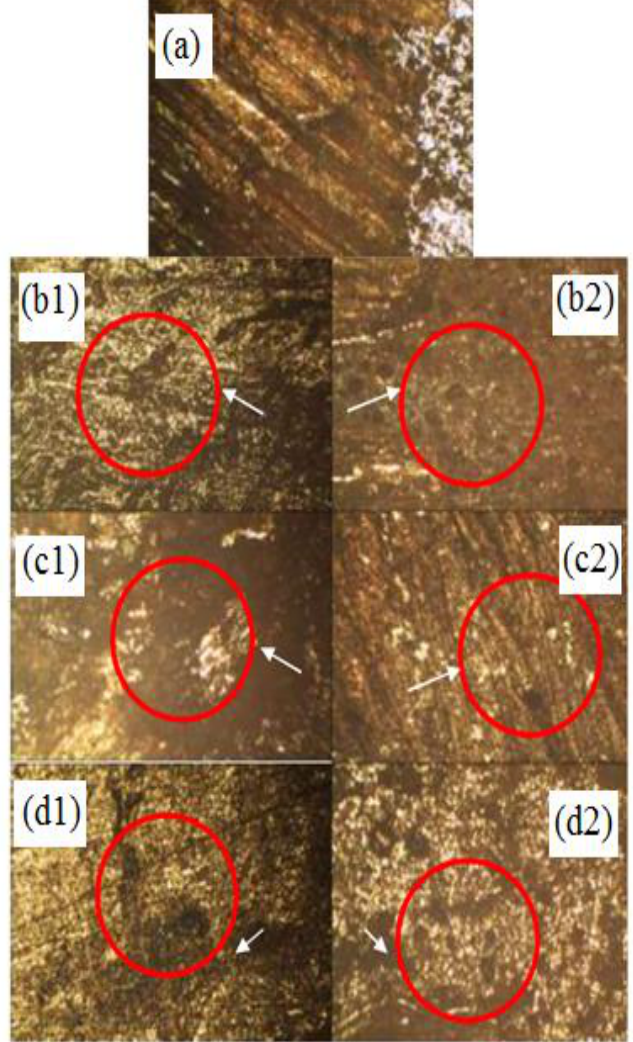
Fig. 4. Surface morphology of the samples immersed in NaCl solution for 2 weeks. (a) Untreated mild steel; (b1) 100 °C heat treated sample and water quenched; (b2) 100 °C heat treated sample and oil quenched; (c1) 300 °C heat treated sample and water quenched; (c2) 300 °C heat treated sample and oil quenched; (d1) 500 °C heat treated sample and water quenched; (d2) 500 °C heat treated sample and oil